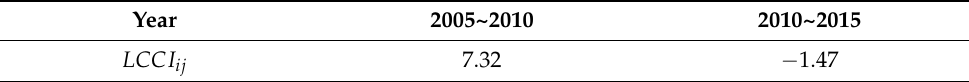
Table 6. Land Cover Change Index of the Loess Plateau Ecological Screen (%).